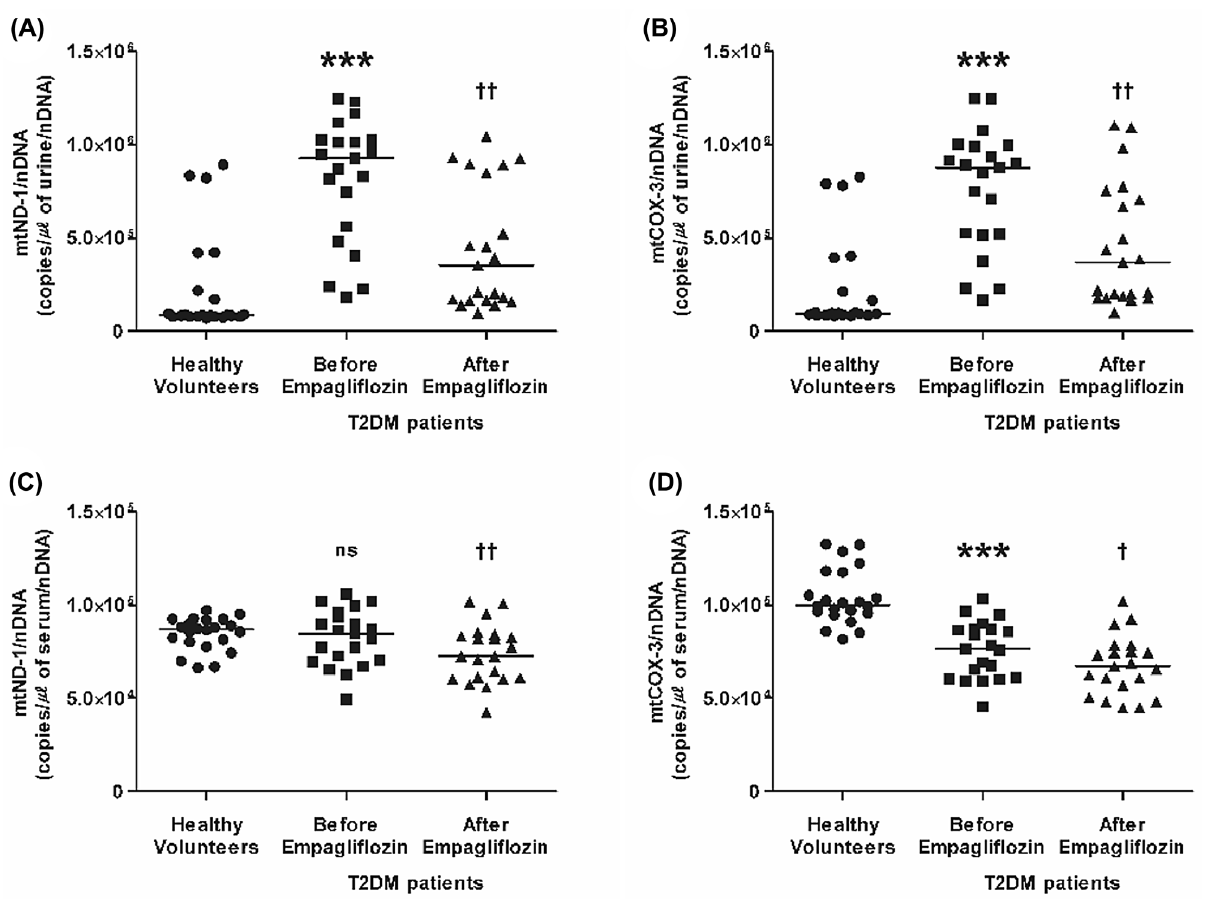
Figure 1. Urinary and circulating mtDNA copy numbers in healthy volunteers ( n = 22) and T2DM patients ( n = 21) before and after empagliflozin treatment. ( A ) Urinary mtND-1, ( B ) urinary mtCOX-3, ( C ) circulating mtND-1, and ( D ) circulating mtCOX-3. Horizontal line represents median. *** P < 0.001 vs. healthy volunteers, † P < 0.05 vs. before empagliflozin treatment, †† P < 0.01 vs. before empagliflozin treatment. Statistical analysis was performed using SPSS (version 25.0, SPSS, Chicago, IL, USA, www. ibm. com/ analy tics/ spss- stati stics- softw are) and figure was plotted using GraphPad Prism (version 5.03, GraphPad Software, San Diego, CA, USA, www. graph pad. com). mtCOX-3 cytochrome-c oxidase 3, mtDNA mitochondrial DNA, mtND-1 nicotinamide adenine dinucleotide dehydrogenase subunit-1, nDNA nuclear DNA, ns not significant, T2DM type 2 diabetes